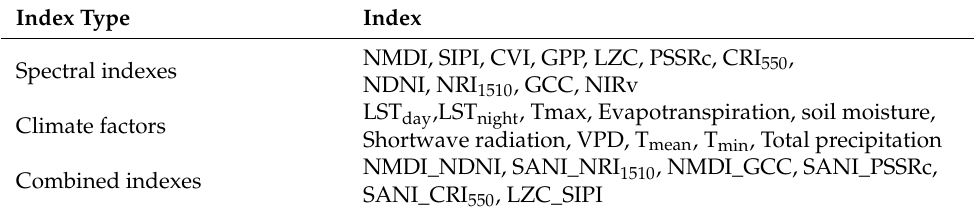
Table 3. Brief descriptions of spectral indexes, climate factors and combined